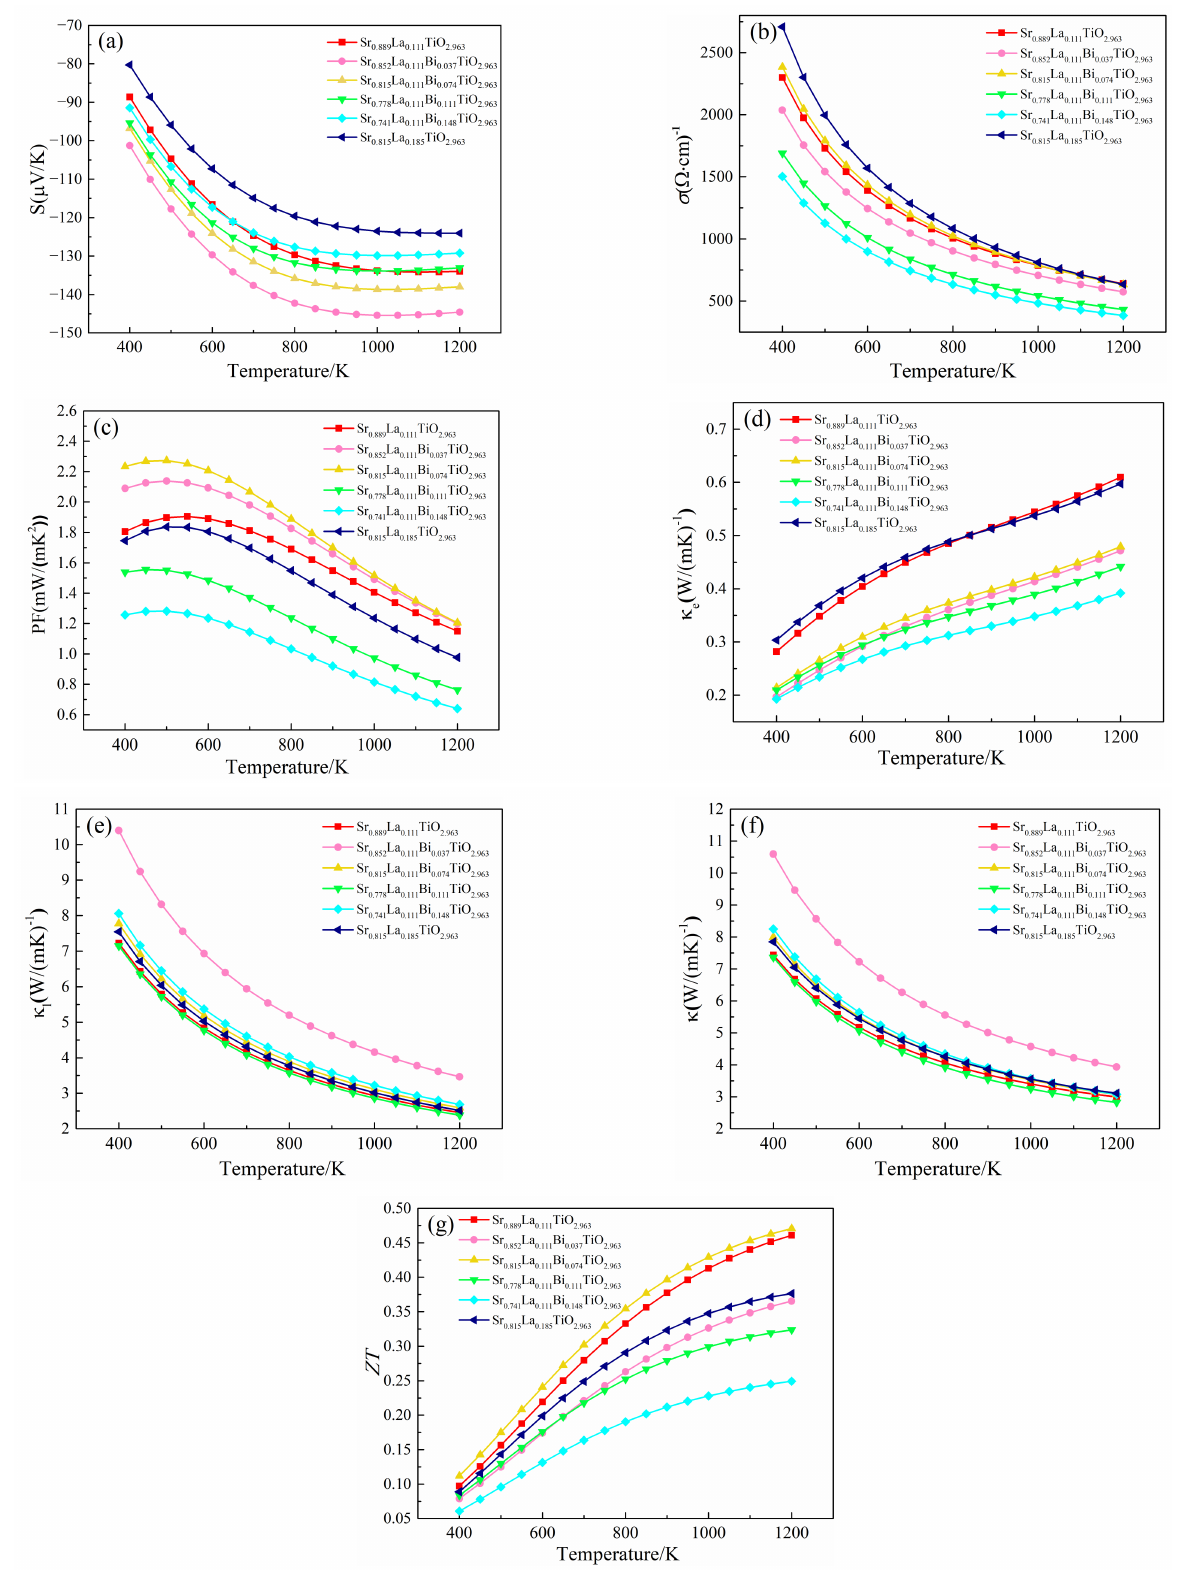
Figure 8. Thermoelectric properties of (Sr 0.889-x La 0.111 Bi x )TiO 2.963 vary with temperature. ( a ) Seebeck coefficient; ( b ) conductivity; ( c ) power factor; ( d ) electronic thermal conductivity; ( e ) lattice thermal conductivity; ( f ) thermal conductivity; ( g ) ZT